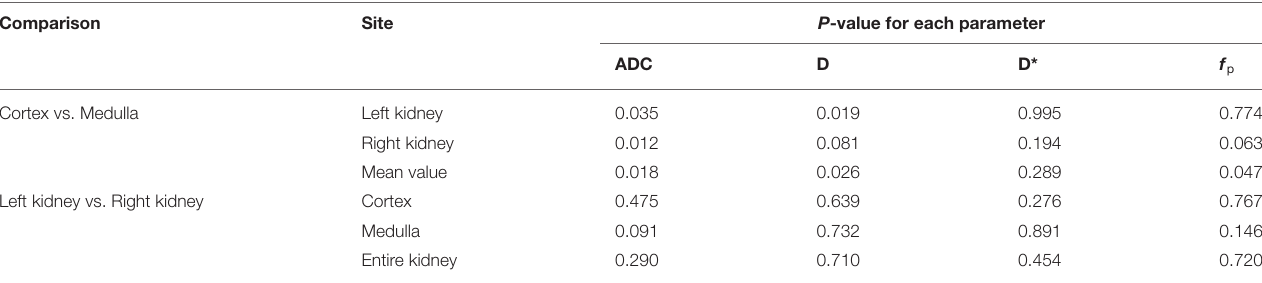
TABLE 3 | Comparison of the ADC, D, D * , and f p between the renal cortex and medulla, and between the left and right kidneys.